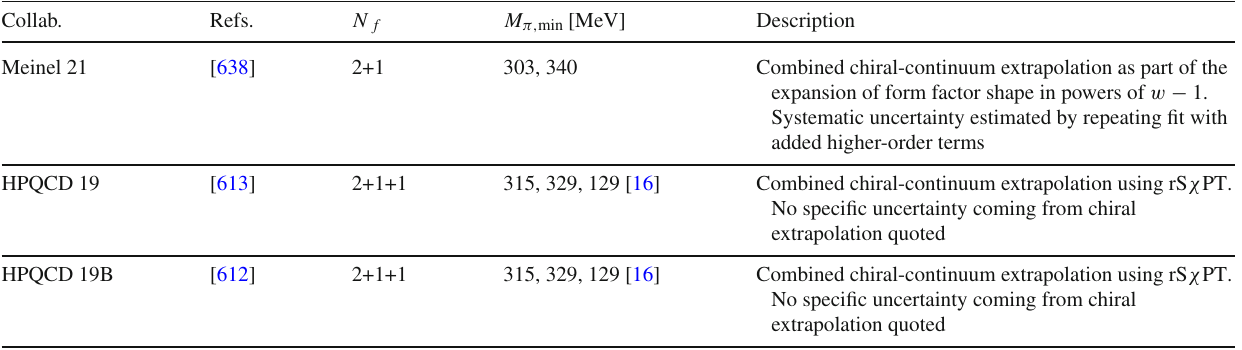
(cid:6)ν and (cid:8) → (cid:8) ( ∗ ) (cid:6) ¯ ν form factors, and of R ( D ( b c s )